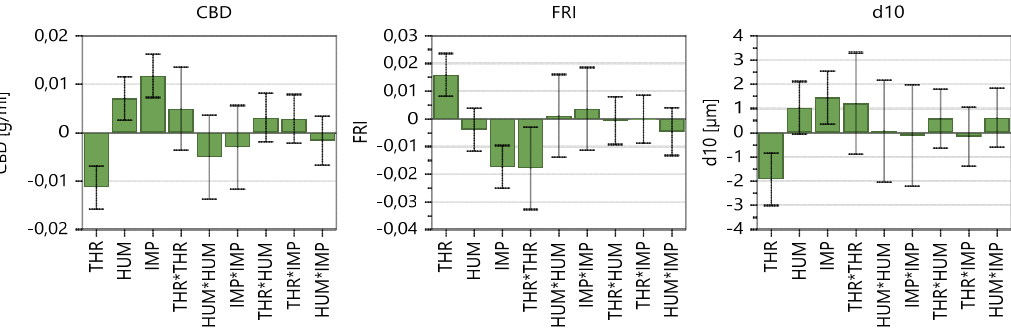
Figure 6. Coefficients plot of model terms regarding material attributes of the blends. The 95% confidence interval is displayed as an error bar.